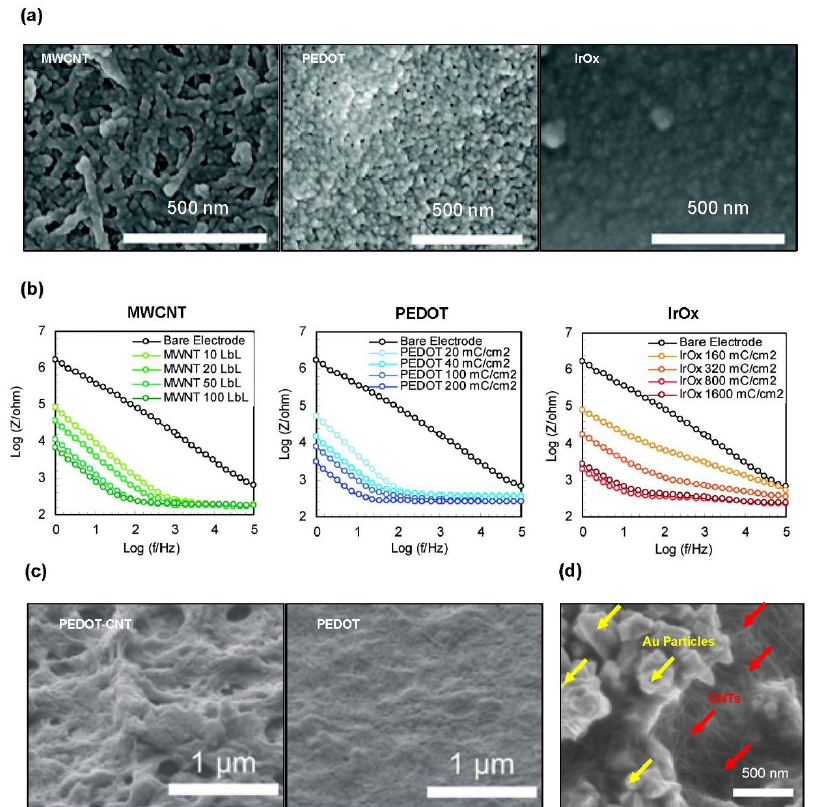
Figure 1. Surface texturing by coating with nanomaterials to lower the electrochemical impedance: ( a ) SEM images of PtIr electrodes coated with multi-walled carbon nanotubes (MWCNTs) (left), poly(3,4-ethylenedioxythiophene) (PEDOT) (middle), and IrOx (right); ( b ) electrochemical impedance spectroscopy (EIS) of three surface-modified electrodes with the increasing film thicknesses over a frequency range of 1–105 Hz. Reproduced with permission from reference [100], Copyright 2009, American Chemical Society; ( c ) SEM images to show the surface morphology of the PEDOT-carbon nanotubes (CNTs) composite (left) and pure PEDOT (right) coatings. Reproduced with permission from reference Gerwig et al. [102], Copyright 2012, Frontiers; ( d ) SEM image of an electrodeposited Au-CNT composite network. Reproduced with permission from reference Xiang et al. [103], copyright 2014, IOP Publishing